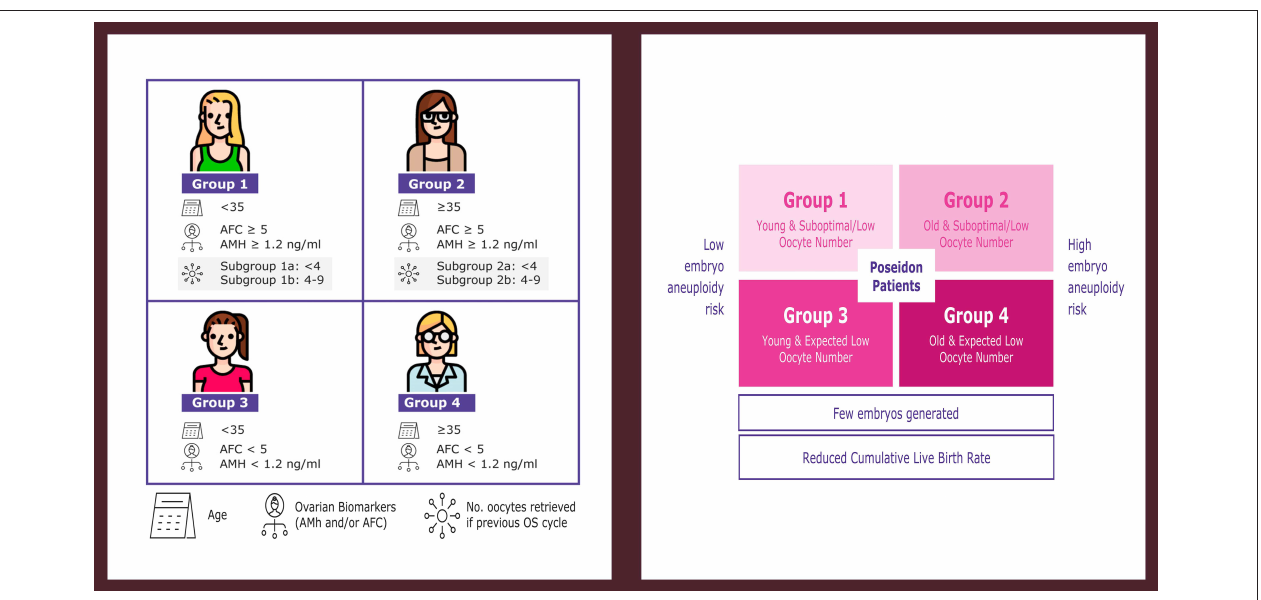
FIGURE 1 | POSEIDON criteria of low prognosis patients in ART. The novel system relies on female age, ovarian reserve markers, ovarian sensitivity to exogenous gonadotropin, and the number of oocytes retrieved, which will both identify the patients with low prognosis and stratify such patients into one of four groups of women with “expected” or “unexpected” impaired ovarian response to exogenous gonadotropin stimulation. According to these criteria, four distinct groups of low prognosis patients can be established (left) . Owing to low oocyte numbers and less embryos produced, POSEIDON patients have lower cumulative live birth rates per started cycle than non-POSEIDON counterparts. However, the prognosis is differentially affected by oocyte quantity and female age, as the latter relates to the risk of embryo aneuploidy (right) . Art drawing by Chloé Xilinas. Modified from Esteves et al. ( 16). This is an open-access article distributed under the terms of the Creative Commons Attribution License (CC BY).